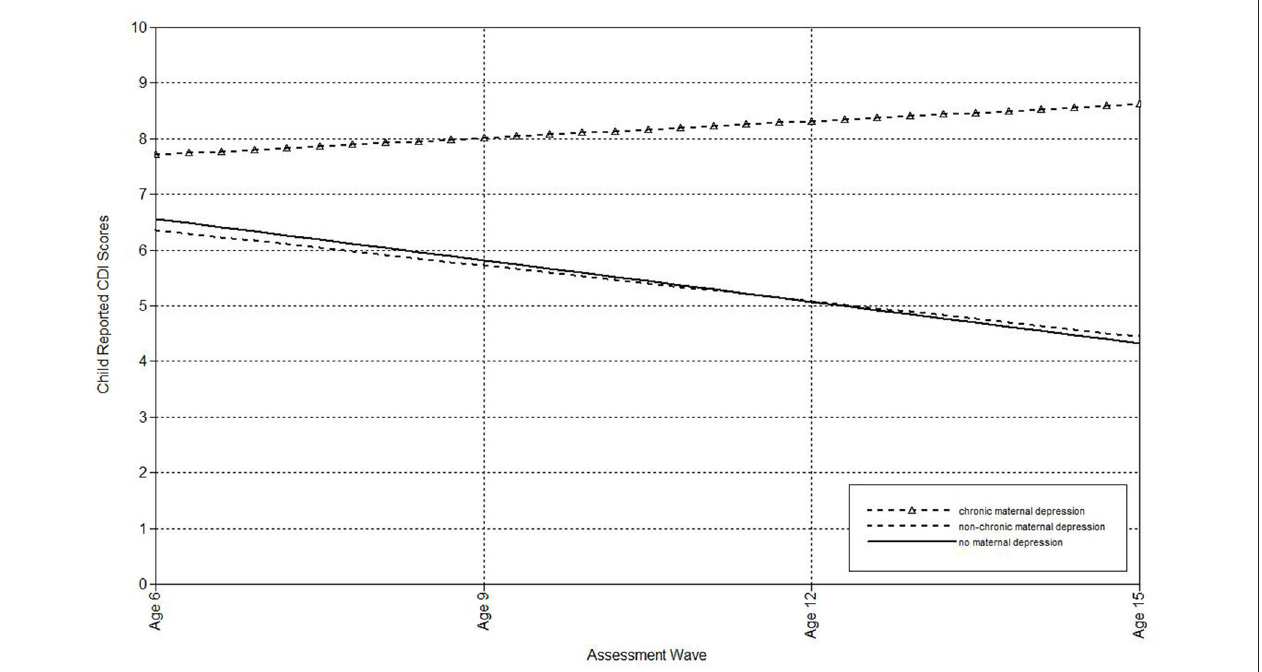
FIGURE 3 | Effect of chronic maternal depression (life-course perspective) on the slope of child-reported CDI scores in